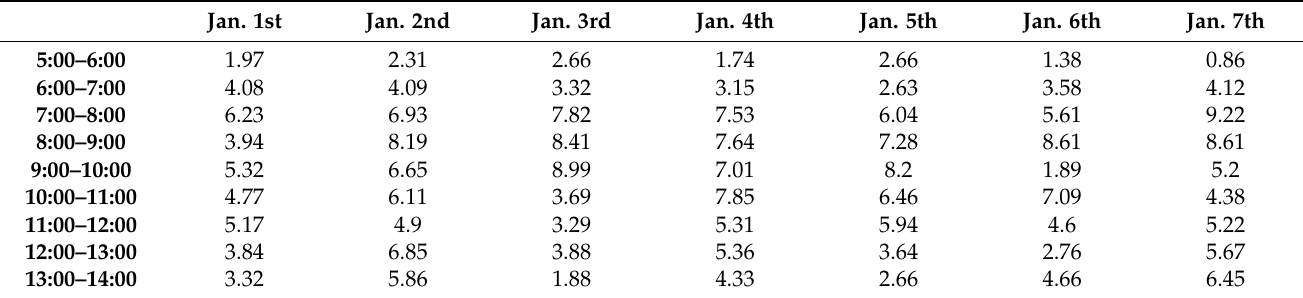
Table 4. H 2 (m) during 5:00–14:00.